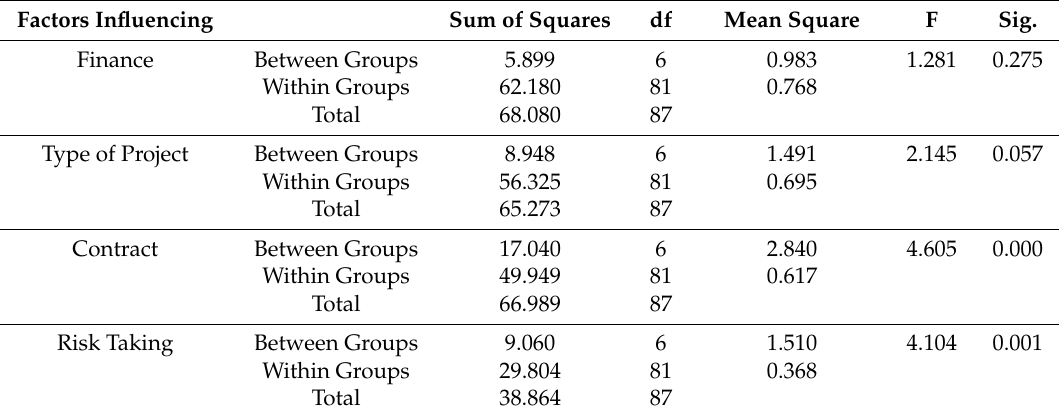
Table 3. ANOVA analysis table for factors influencing a company’s project decision making.